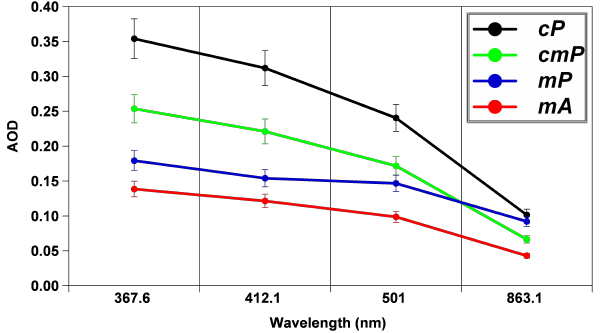
Fig. 16. Aerosol Optical Dept spectral dependence by air mass